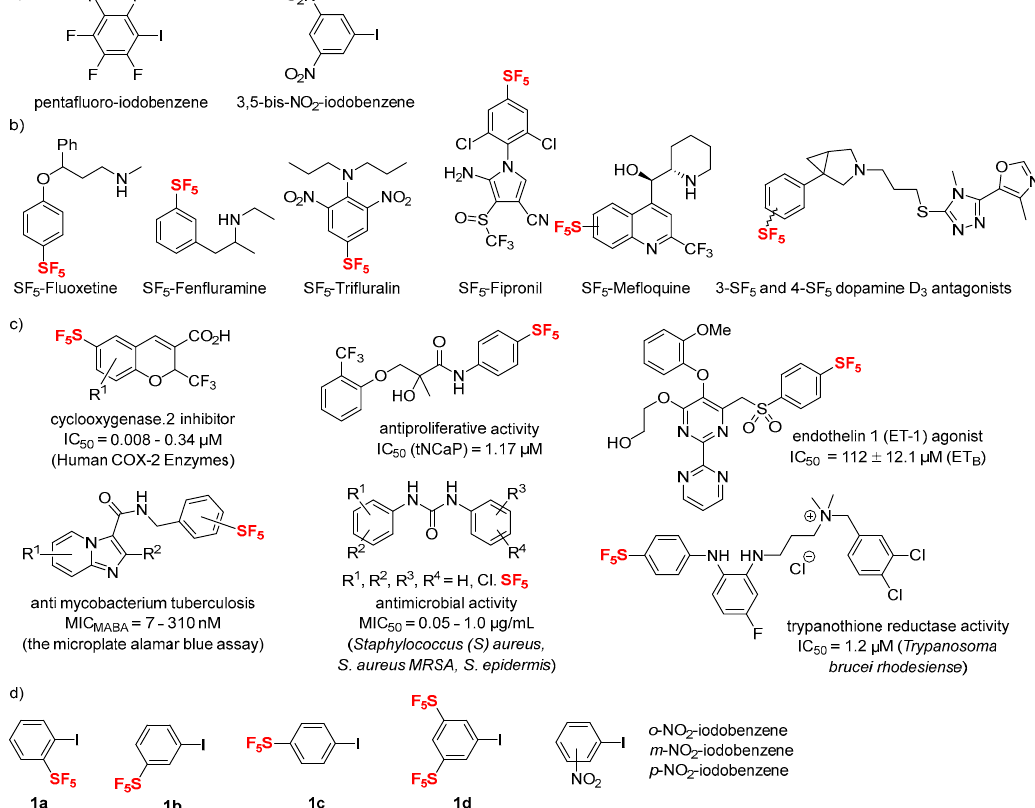
Figure1. ( a )Thestandardhalogenbonddonorspentafluoro-iodobenzeneand3,5-bis-NO 2 -iodobenzene. ( b ) Examples of pentafluoro- λ 6 -sulfanyl (SF 5 )-containing analogs of marketed drugs. ( c ) Examples of SF 5 -containing biologically active molecules. ( d ) Potential halogen bond donors of aryl iodide containing SF 5 -group(s) and NO 2 -iodobenzenes (this